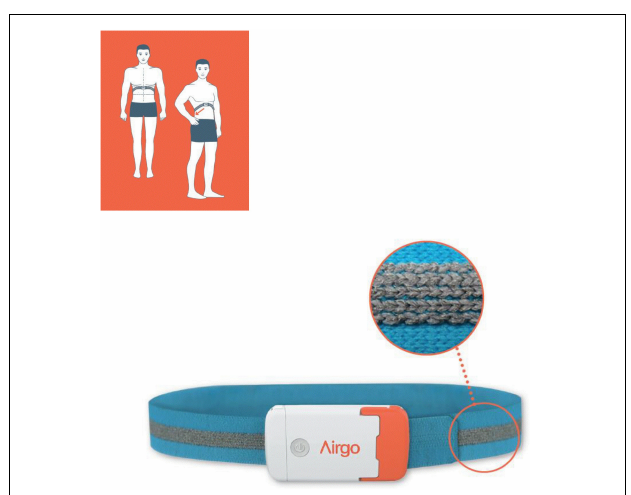
FIGURE 1 | The wearable device consists of an elastic band incorporating a silver-coated electrically conductive yarn (see detail), coupled with a microprocessor embedded in an ABS shell. The figure shows the proper placement